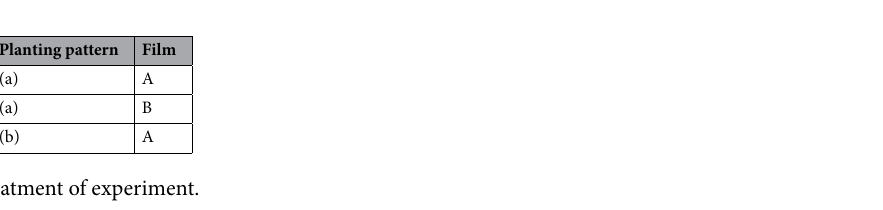
Figure 1. Planting pattern diagram. ( a ) Micro-ridge-furrow rainwater harvesting with mulching planting pattern; ( b ) Traditional flat-cropping planting pattern.